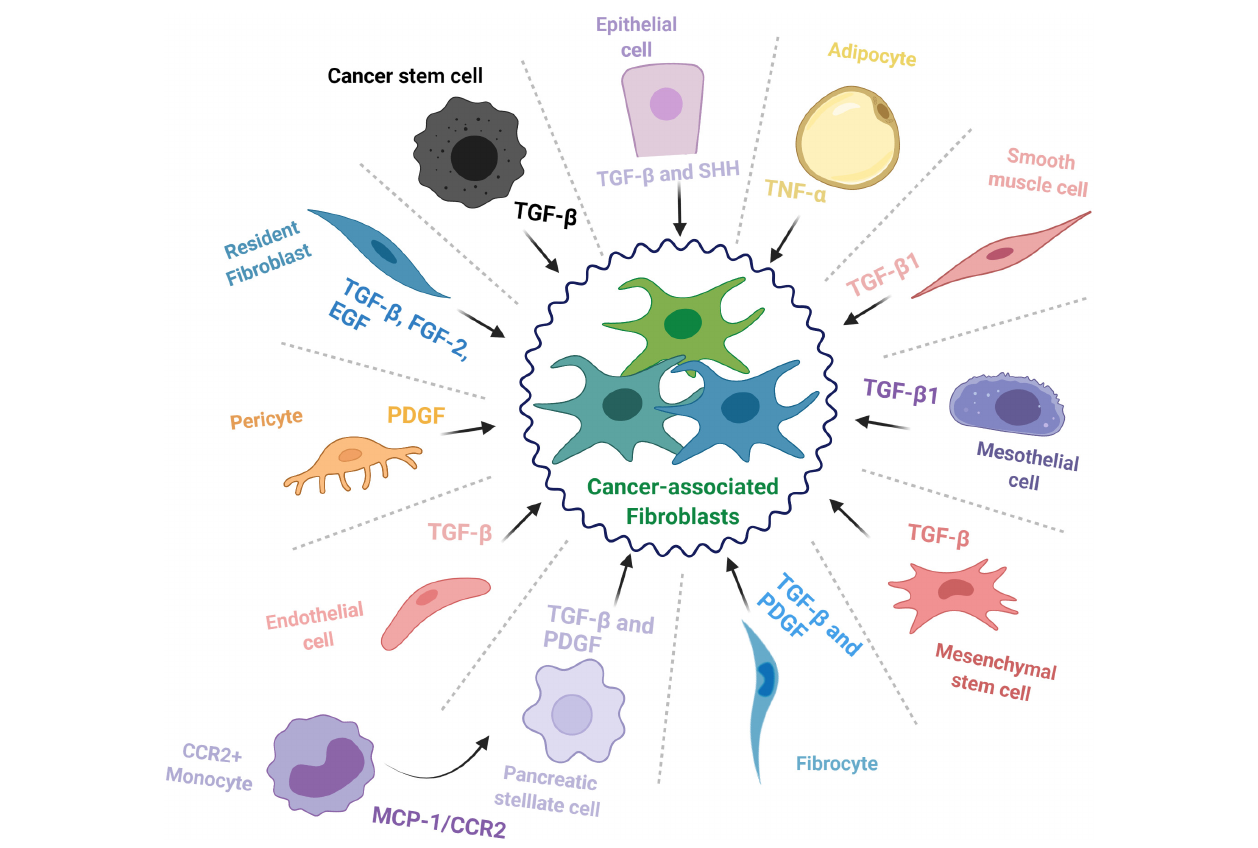
FIGURE 1 | The cellular origins of cancer-associated fibroblasts. The cell types that contribute to the cancer-associated fibroblast (CAF) population and some of the major factors and signaling pathways involved in the transition toward a CAF